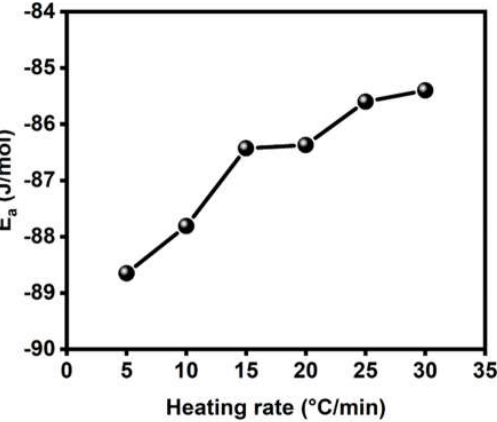
Figure 8. Activation energies calculated based on the contracting volume model (R3) at various heating rates. heating